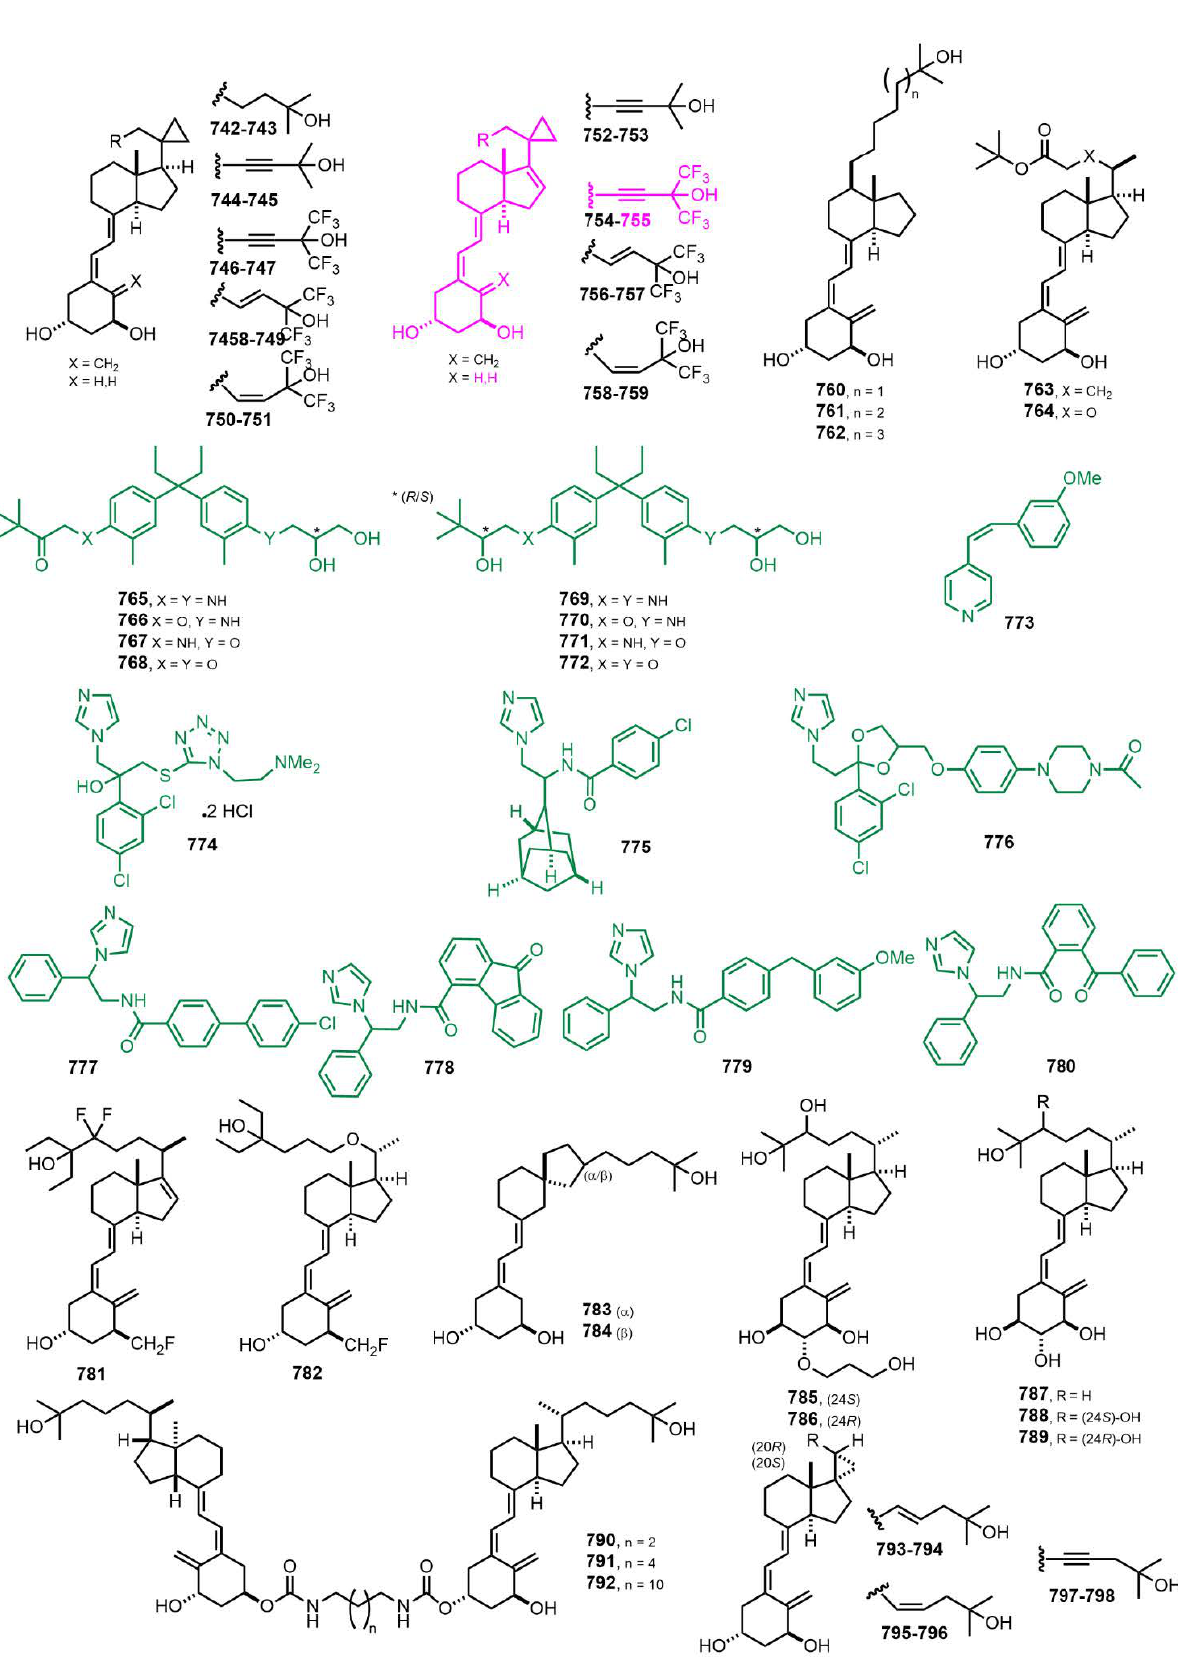
Figure 15. (2006–2007)